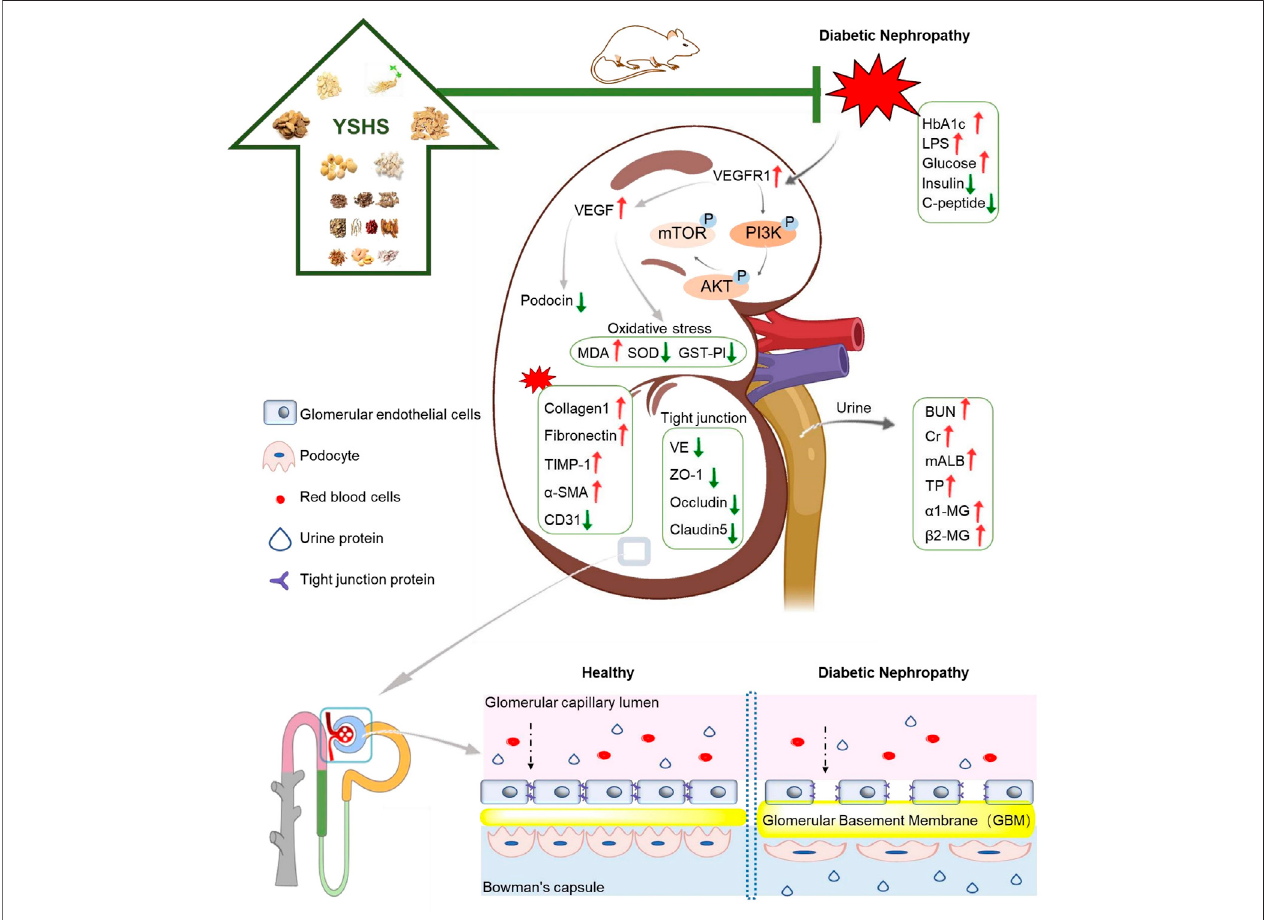
FIGURE 11 | Proposed mechanism of YSHS on protecting the glomerular fi ltration barrier under DN settings.